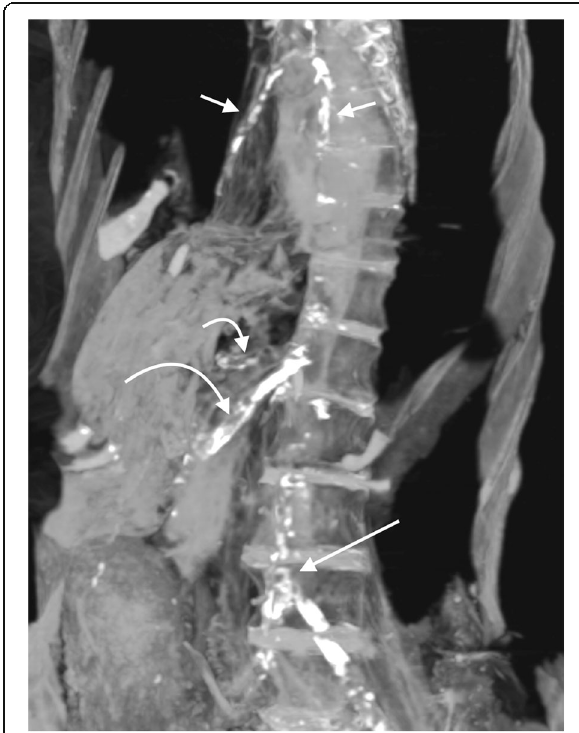
Fig. 7 Computed tomography images of “ Unknown-Woman-A ” mummy show advanced diffuse atherosclerosis. Coronal thick slab three-dimensional reconstructed computed tomography image of the torso of mummy “ Unknown-Woman-A ” shows extensive vascular calcifications (atherosclerosis). The high-density calcification lesions involve the right and left coronary arteries (short straight arrows), celiac artery (short curved arrow), superior mesenteric artery (long curved arrow), and aorto-iliac bifurcation (long straight